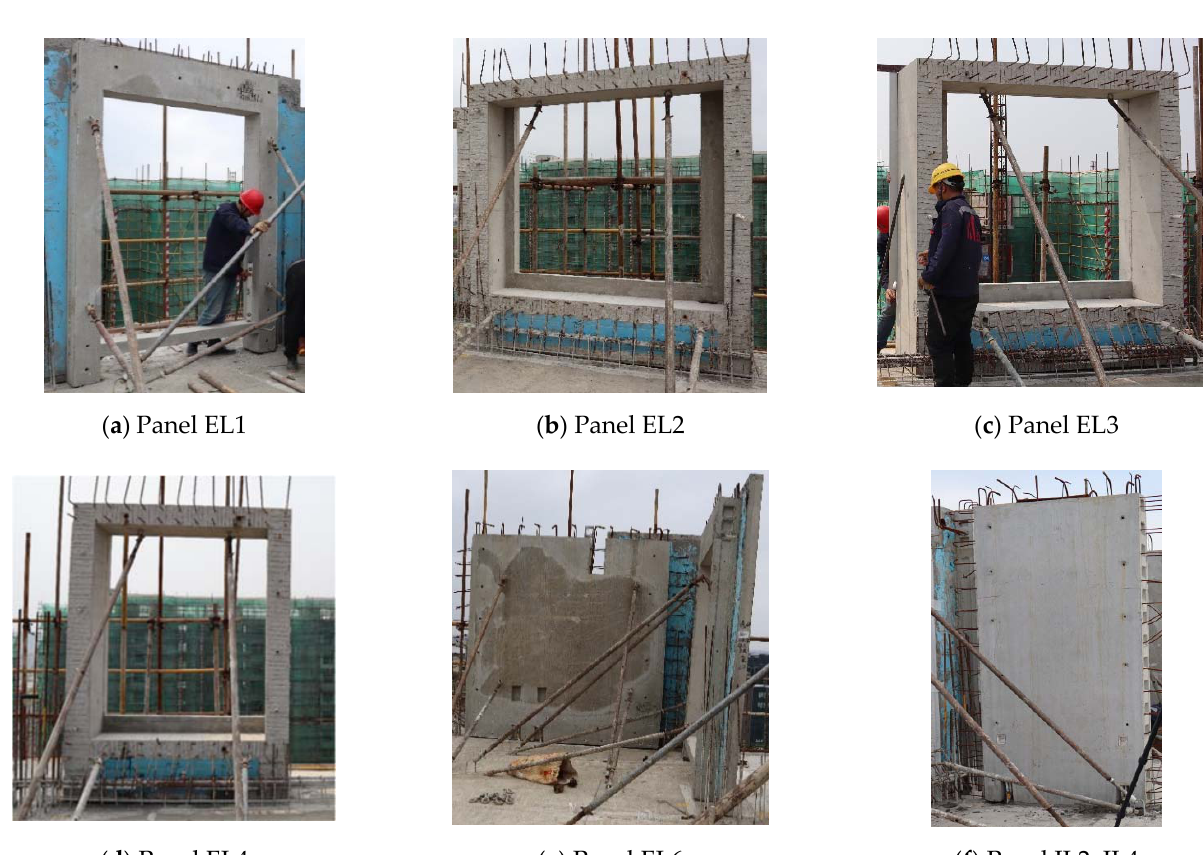
Figure 7. Selected area of the case study.